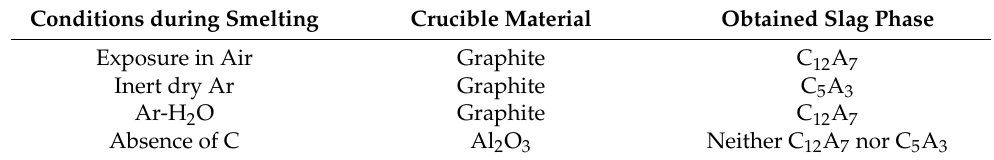
Table 5. Impact of atmospheric conditions during smelting and crucible material on the obtained slag